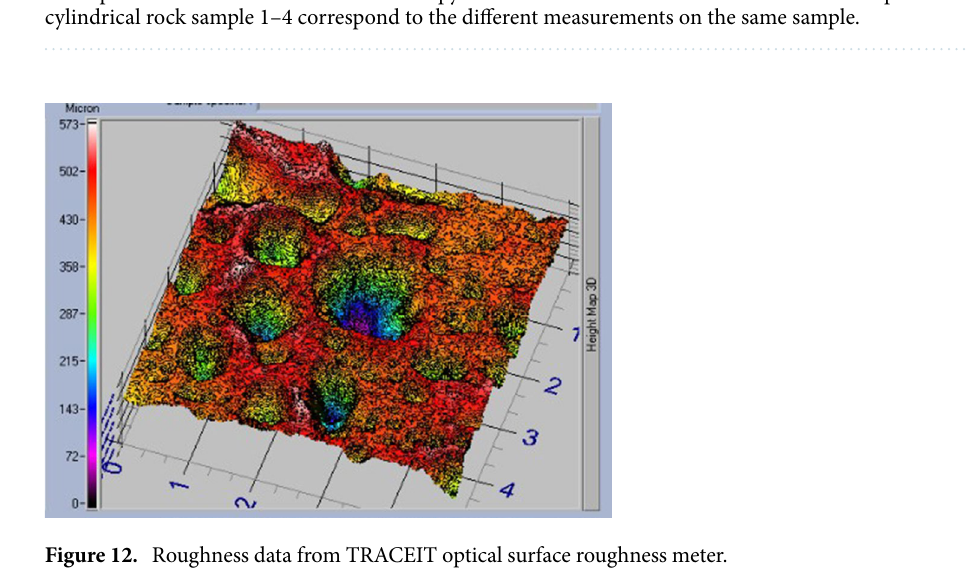
Table 5. Ultrasound pulse velocity test and anisotropy results where Vmed corresponds to: Medium Velocity, StD Med: Medium Standard Deviation, dM: Total Anisotropy and dm: Relative Anisotropy. *dM and dm correspond to the total and relative anisotropy of the basalts. r indicates that the test has been performed on a cylindrical rock sample 1–4 correspond to the different measurements on the same sample.